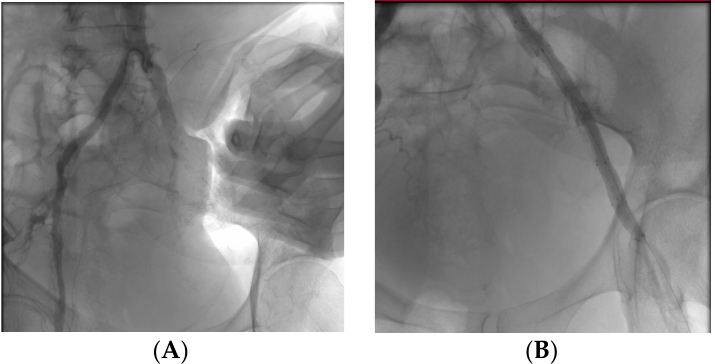
( B ) Figure A2. Intra-operative ( A ) and post-operative ( B ) angiogram. Appendix A.4. Case Report: Leriche Syndrome